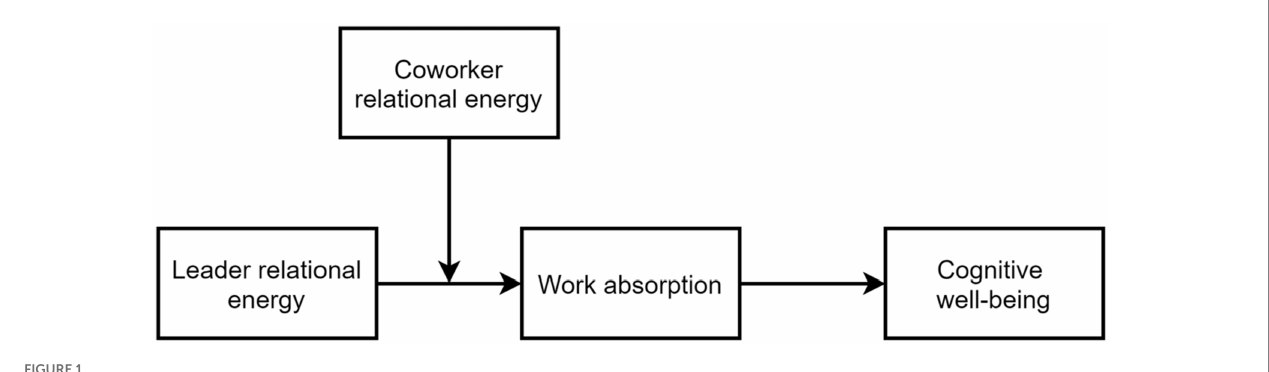
FIGURE 1 Theoretical